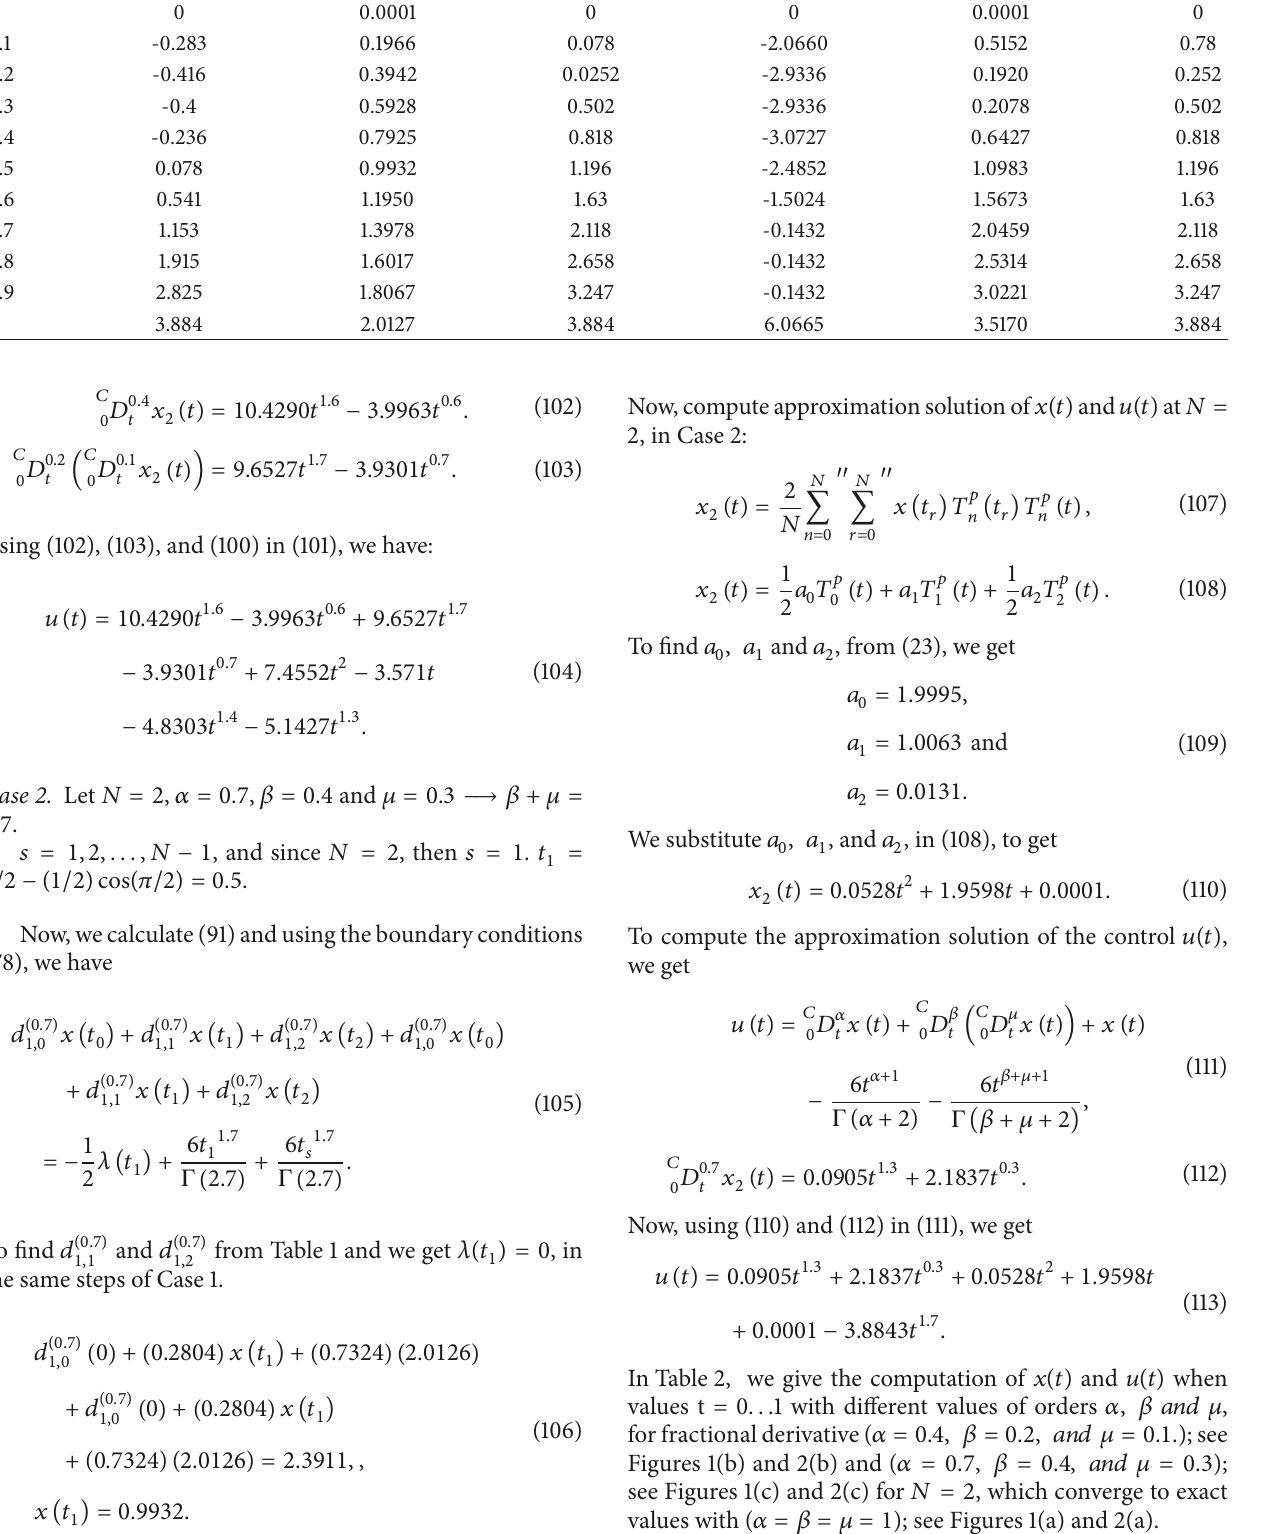
Table 2: The numerical values of the state 𝑥(𝑡) and control 𝑢(𝑡) with 𝑁 = 2 which converged to exact values are shown. 𝛼 = 0.4 𝛼 = 0.7 𝛼 = 1 𝛼 = 0.4 𝛼 = 0.7 𝛼 = 1 𝑡 𝛽 = 0.2 𝛽 = 0.4 𝛽 = 1 𝛽 = 0.2 𝛽 = 0.4 𝛽 = 1 𝜇 = 0.1 𝜇 = 0.3 𝜇 = 1 𝜇 = 0.1 𝜇 = 0.3 𝜇 = 1 0 0 0.0001 0 0